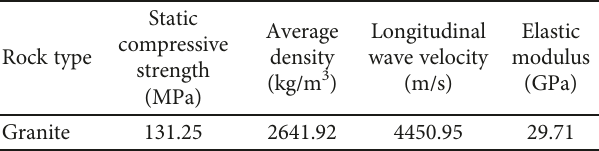
Figure 1: Petrographic microscopy and the surface images of the granite: (a) petrographic microscopy image of the granite; (b) surface image of the granite. Qtz: quartz; Bt: biotite; Kfs: K-feldspar. Table 1: The basic properties of